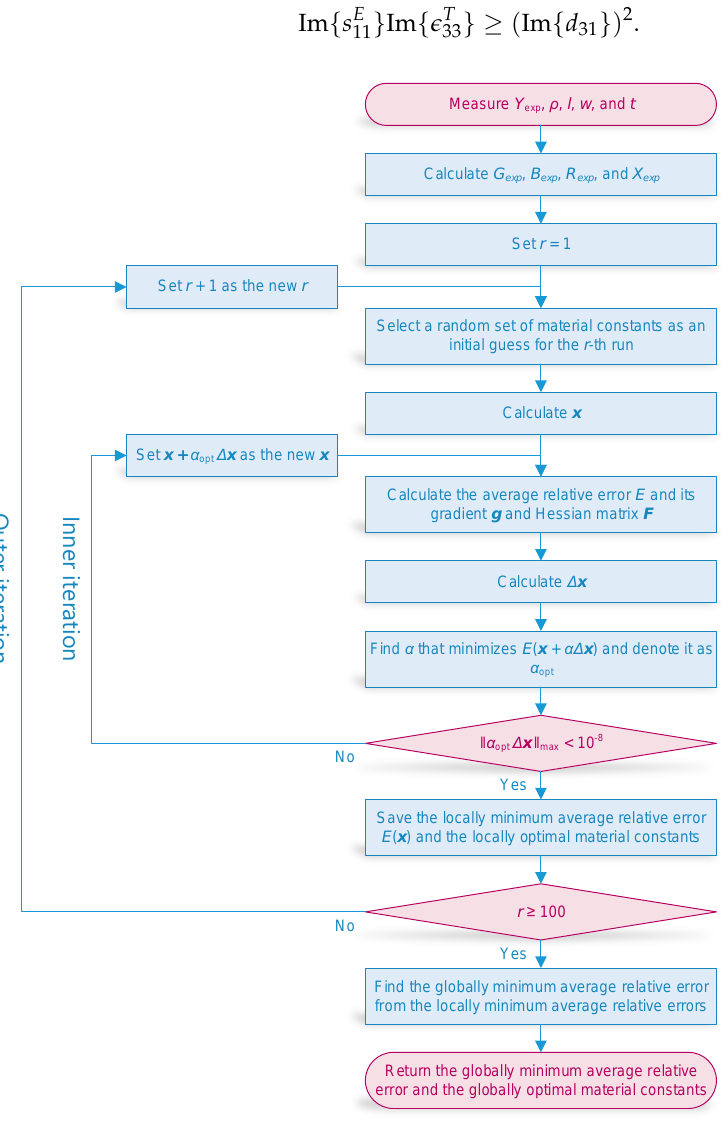
Figure 1. The flow chart of the global optimization